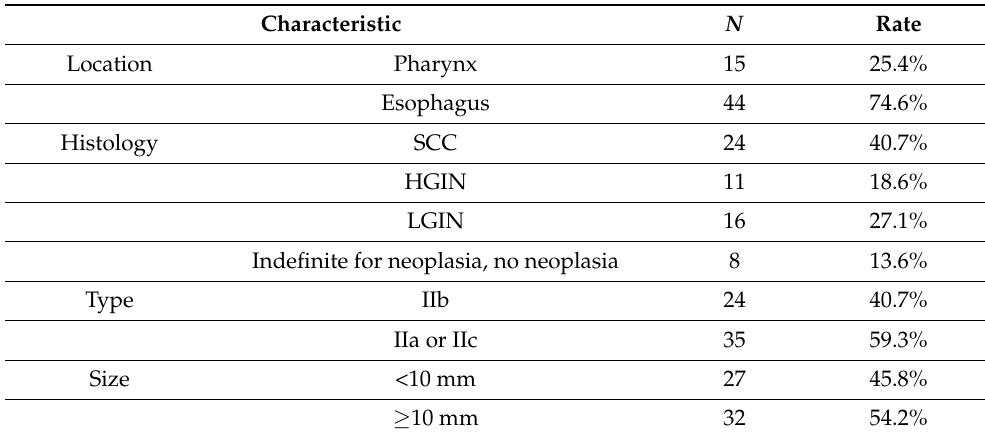
Table 1. Demographics of the squamous cell carcinoma suspicious lesions.